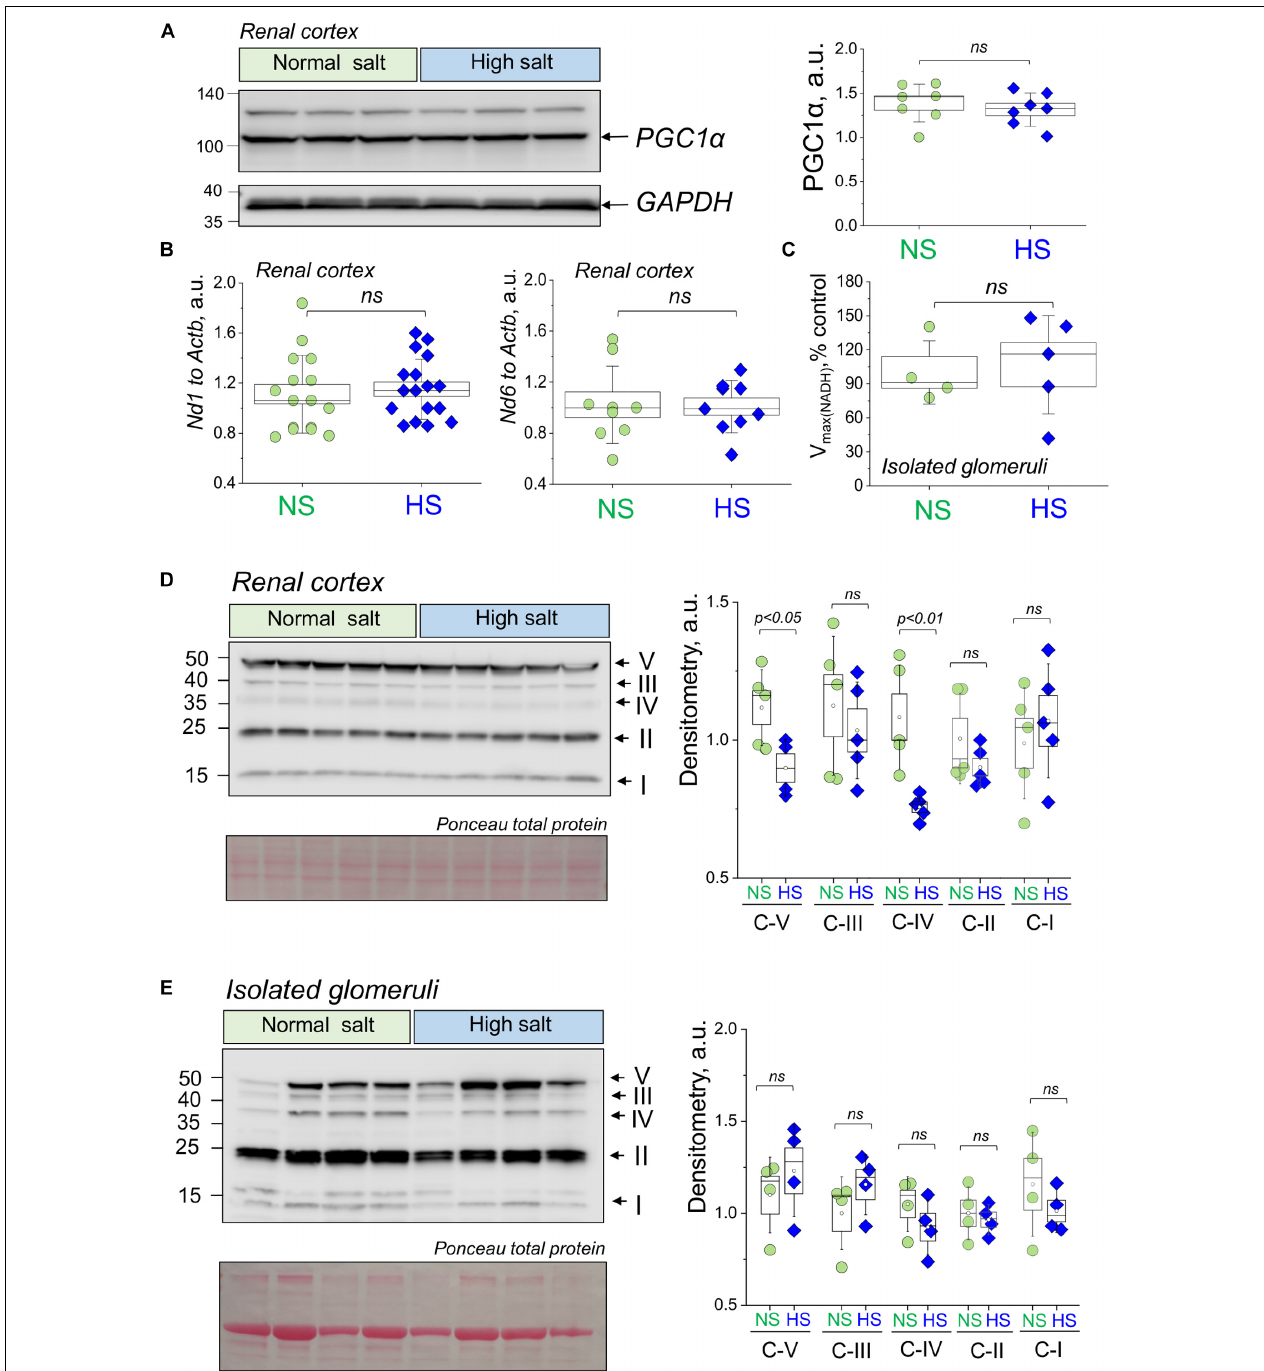
FIGURE 2 | Renal mitochondria biogenesis and electron transport chain (ETC) complexes expression and activity during salt-sensitive (SS) hypertension. (A) Representative Western blot showing expression of PGC1 α in the renal cortex of the HS and NS diet fed animals. Graph on the right summarizes densitometry values from the Western blot shown on the left combined with another (independent) Western run on other samples (data not shown). All data were normalized to GAPDH expression level. N = 7 individual rats tested in each group. (B) Mitochondrial DNA content in the renal cortex of rats fed a HS or a NS diet. Shown are results of qPCR for mitochondria genome encoded genes Nd1 and Nd6 (values normalized to nuclei-encoded Actb ). (C) ETC Complex V activity as measured in the glomeruli isolated from NS and HS diet fed rats. Data were normalized to protein level, n = 5 animals per group. (D,E) Western blot analysis illustrating the expression of ETC complexes V, IV, III, II, and I in the renal cortex (D) and isolated glomeruli (E) from HS and NS diet fed Dahl SS rats. Graph on the right summarizes densitometry values (normalized to total protein as measured with Ponceau stain). NS, normal salt; HS, high salt; ns, not statistically significant ( p > 0.05). All data were compared using a one-way ANOVA with Holm–Sidak post hoc test. Each lane on the Western is a sample from a separate animal.